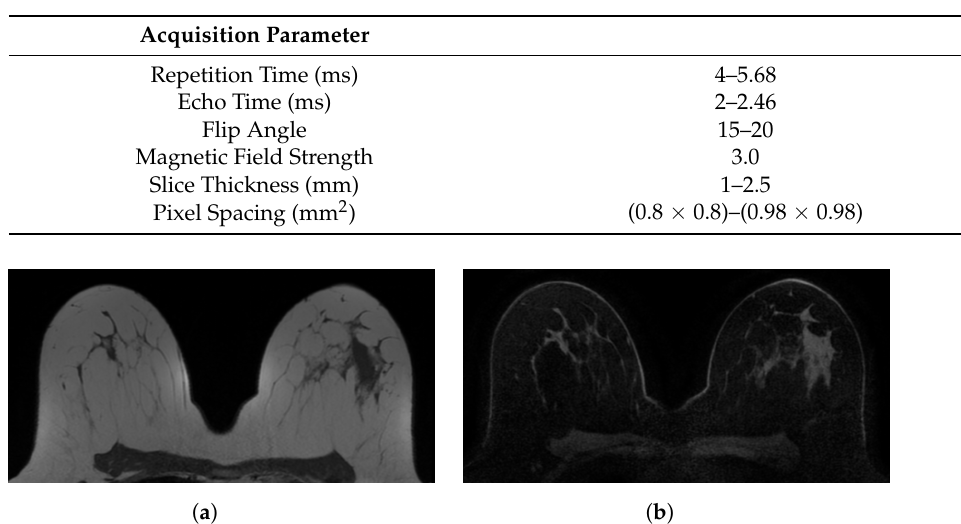
Table 1. Breast DCE-MRI acquisition parameters for internal dataset.